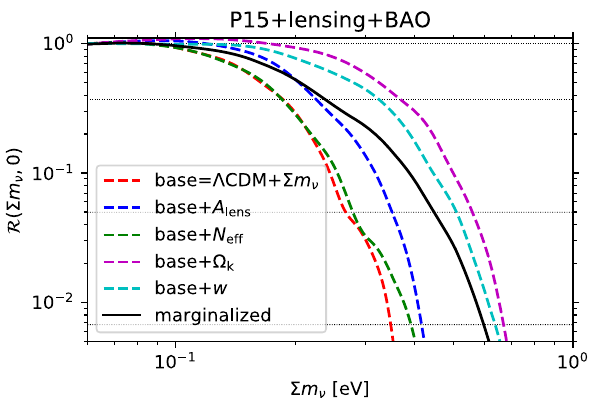
Fig. 3 The R (Σ m ν , 0 ) function in Eq. (9) obtained considering dif- ferent models (dashed) together with the model-marginalized one from Eq. (17) (solid), using the full dataset adopted in Ref. [27] (see text for details). The horizontal lines show the levels ln R = 0, − 1, − 3, − 5,